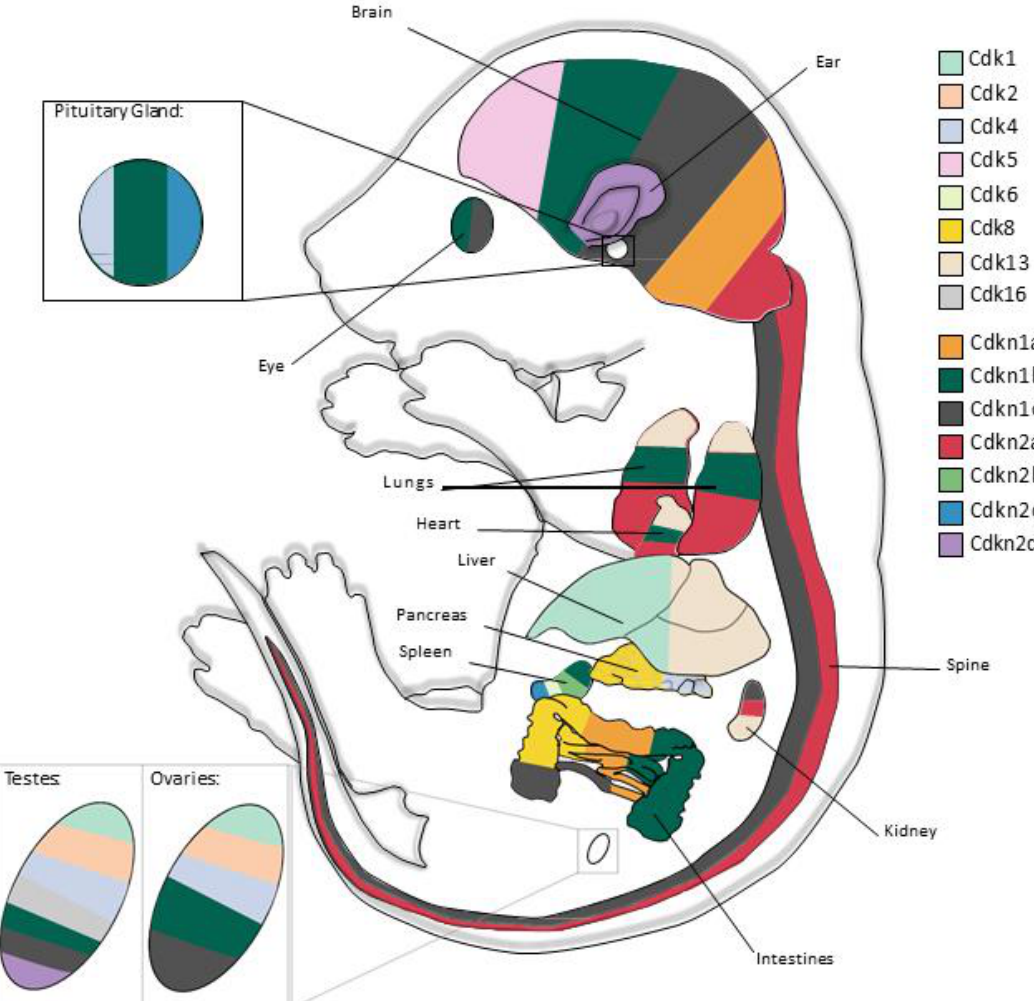
Figure 1. Schematic of principal areas of CDK and CDKI involvement during murine development, as determined by KO and cKO mouse models. The ears, brain, pituitary gland, eyes, spine, lungs, heart, liver, pancreas, kidneys, spleen, intestine and testes / ovaries are colour-coded based on the presence of an altered phenotype upon KO of a CDK or CDKI, depicted here in an E17.5 mouse embryo. The area of each colour is not reflective of the magnitude of the e ff ect on the mouse phenotype. KOs of Cdk1 , Cdk4 , Cdk6 , Cdk11 , Cdk13 , Cdkn1b , Cdkn1c and Cdkn2c a ff ect overall embryonic